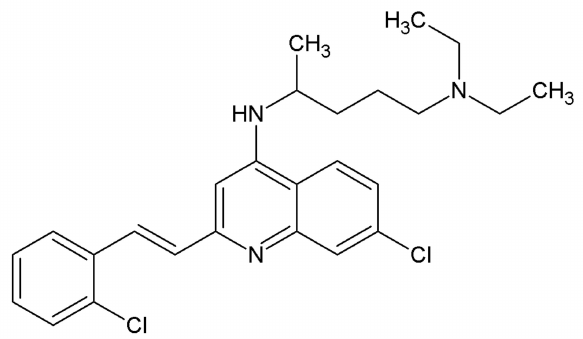
Chemical structure of the positive allosteric modulator of GFL signaling, the compound